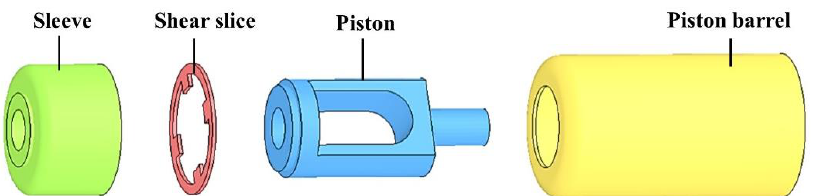
Figure 6. Geometrical model of propellant actuator.